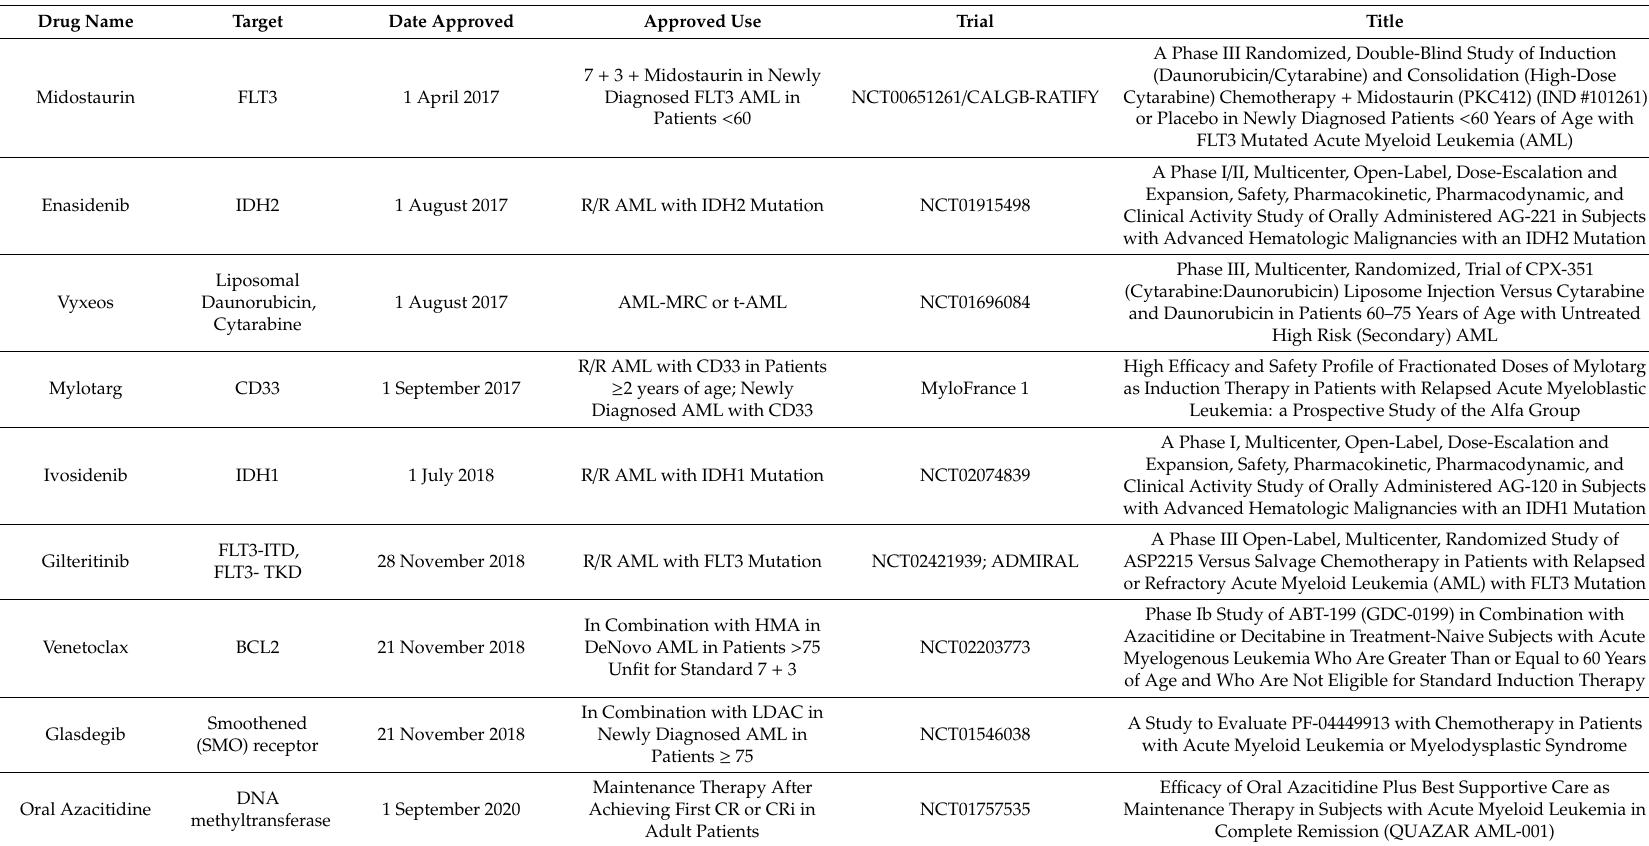
Table 1. Recently approved therapies in acute myeloid